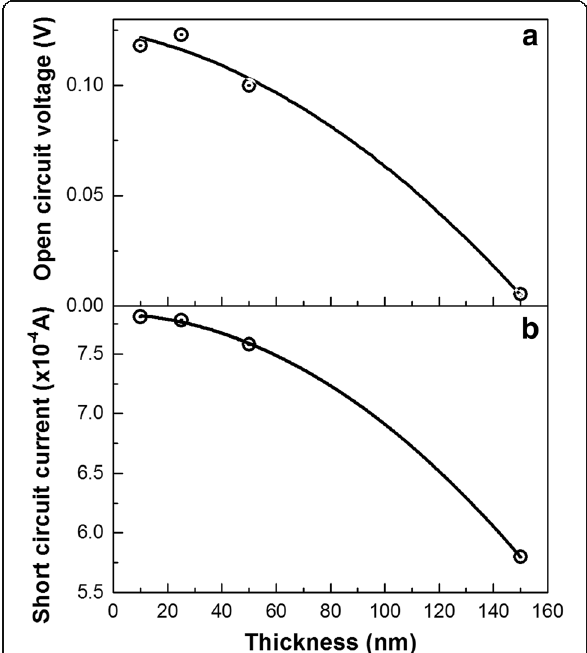
Fig. 7 Open circuit voltage ( a ) and short circuit current ( b ) of DLC:Ag/p-Si heterojunction vs nanocomposite film thickness. Solar simulator with AM1.5 spectra was used for the